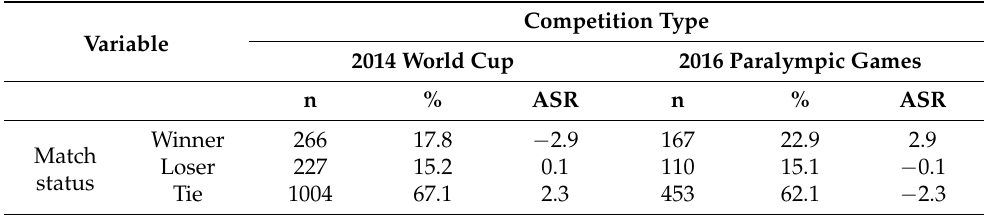
Table 3. Descriptive results and the ASRs of the match status variable.